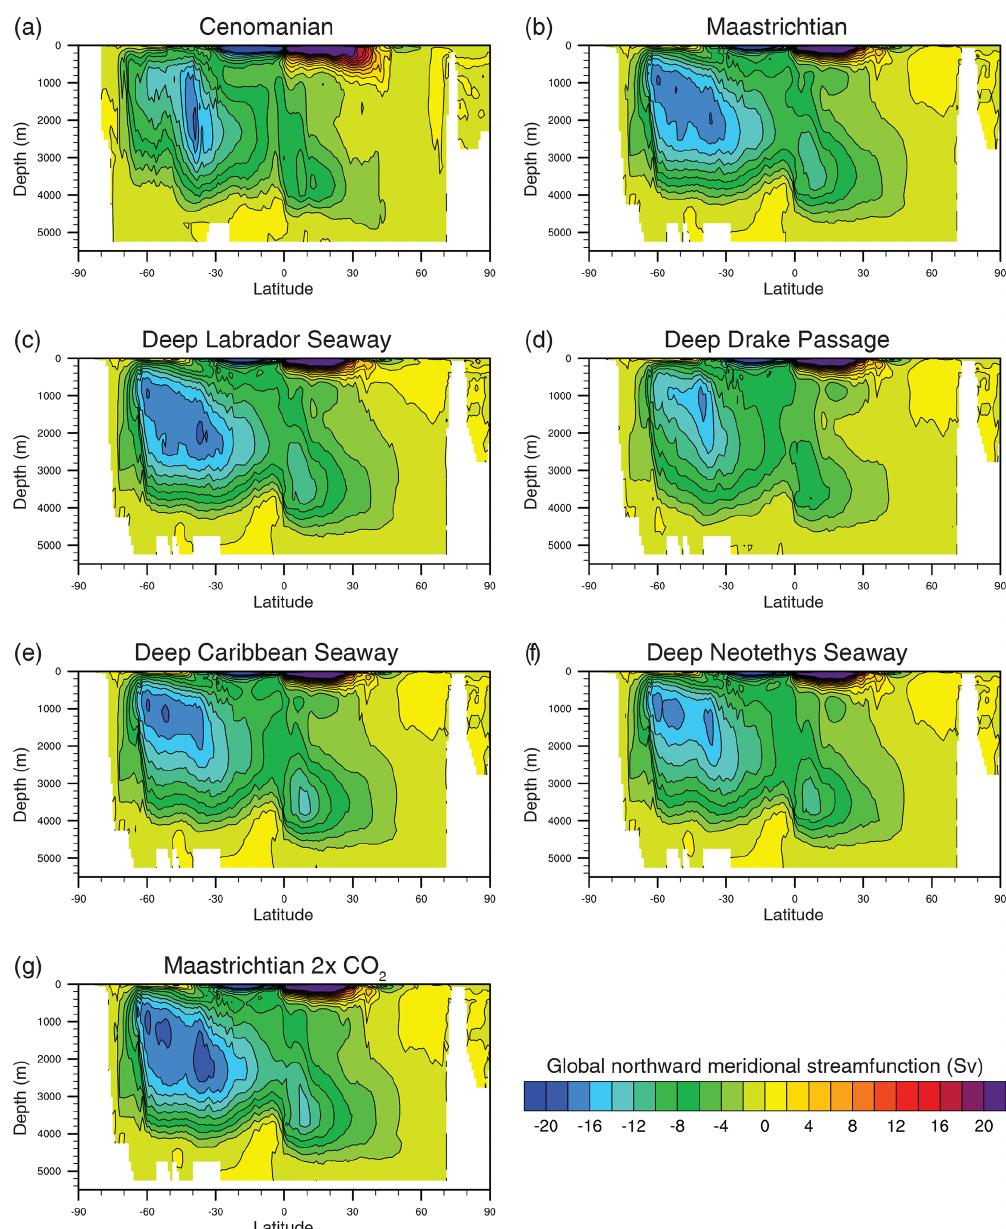
Figure 4. Global meridional overturning circulation (clockwise positive) for each experiment. (a) Cenomanian, (b) Maastrichtian, (c) Deep Labrador Seaway, (d) Deep Drake Passage, (e) Deep Caribbean Seaway, (f) Deep Neotethys Seaway, and (g) 2 × CO 2